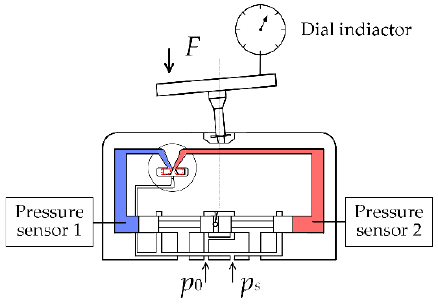
Figure 12. Devices and experimental method.